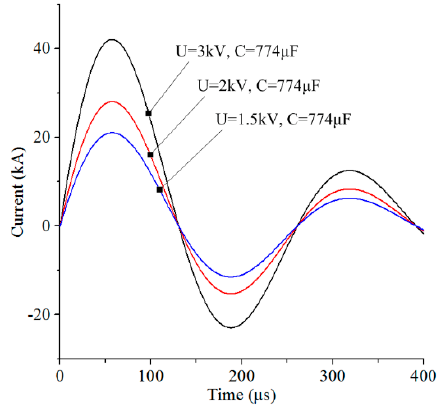
Figure 4. Current through the coil as a function of time.